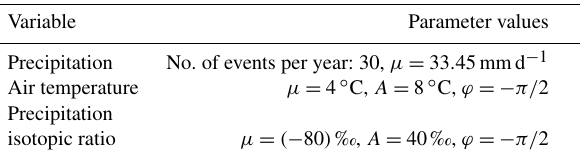
Table 4. Parameters used to generate time series of precipitation, air temperature, and isotopic ratios in precipitation. µ represents the mean, A is the amplitude, and ϕ is the time lag of the underlying sine function. For the precipitation process, µ is the mean intensity on days with precipitation. The resulting mean winter length (air temperature below 0 ◦ C) is